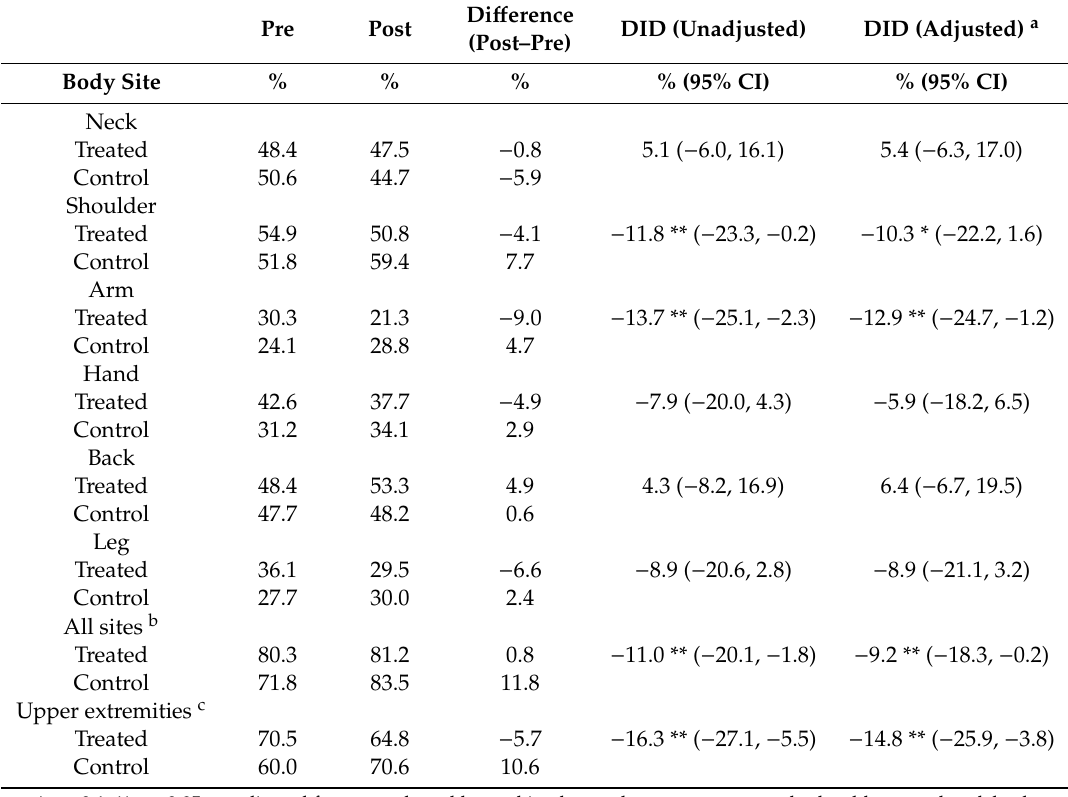
Table 2. Di ff erence-in-di ff erence analysis results for the prevalence of musculoskeletal